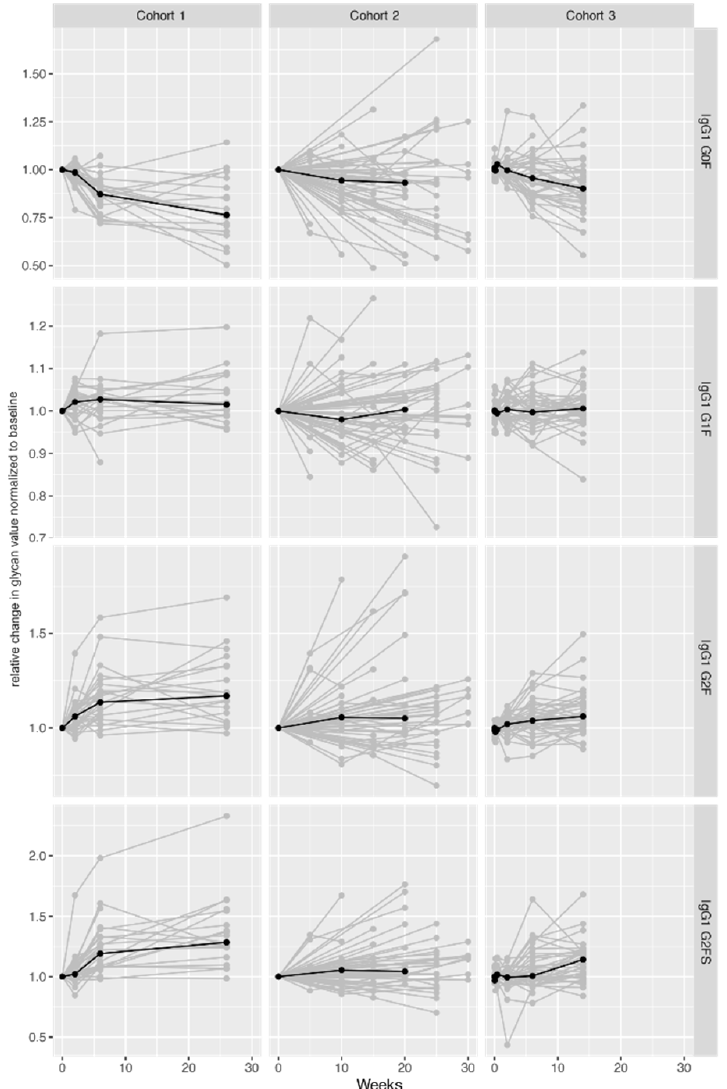
Figure 2. Changes in IgG1 Fc glycan profiles during treatment in three cohorts of UC and CD patients. Median glycan values for each time point are bolded. Y-axis: relative change in glycan value normalized to baseline (1st timepoint); X-axis: duration of follow-up (weeks). Results of meta-analysis are shown in Table 1, while the results of statistical analysis for individual cohorts are shown in Table